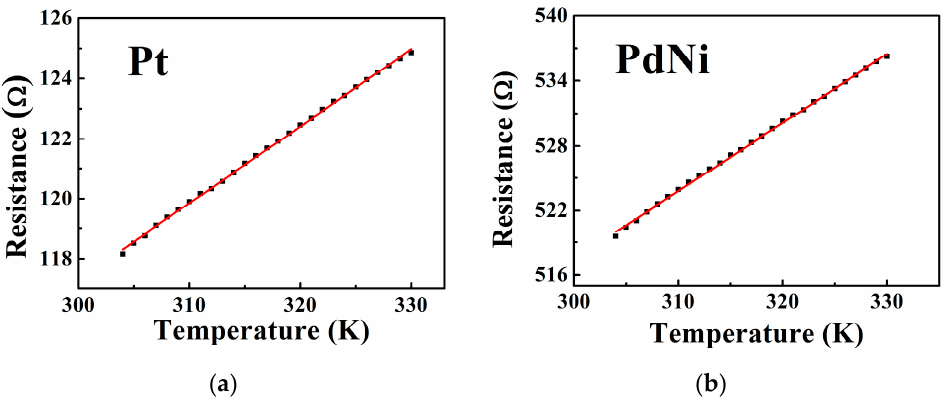
Figure 4. The resistance variations of the Pt ( a ) film and PdNi ( b ) film with temperatures.